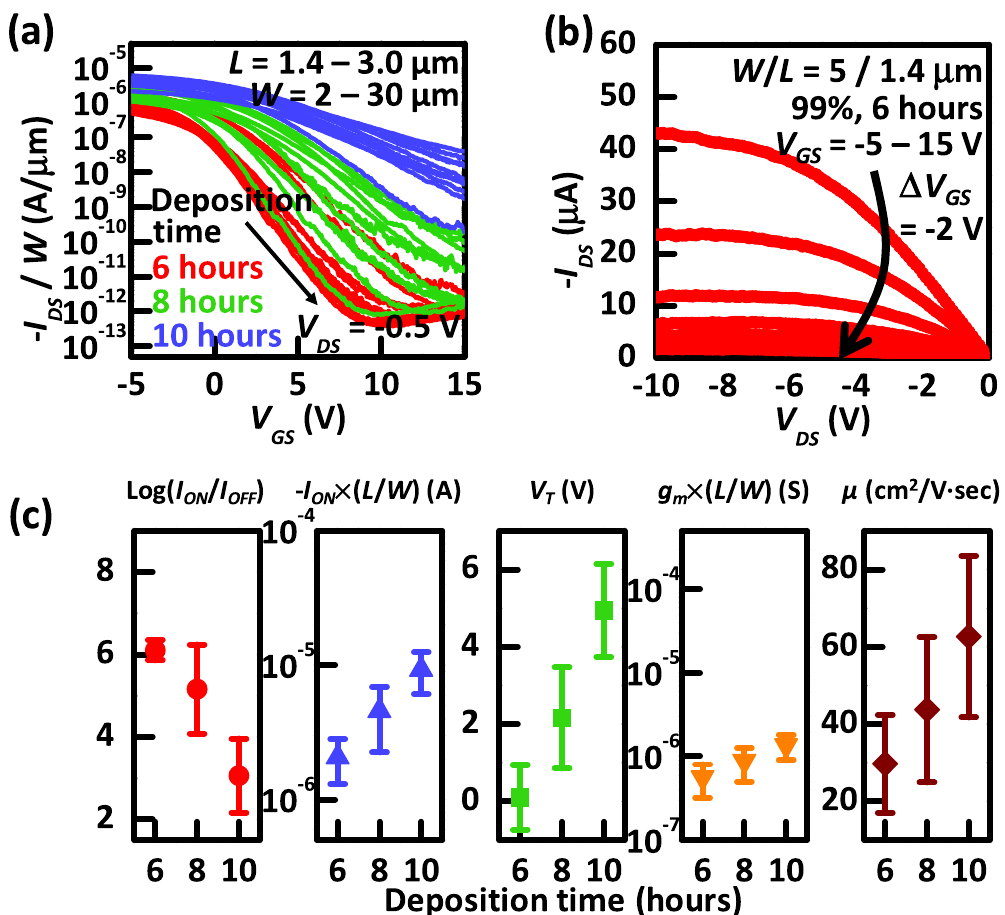
Figure 2. ( a ) Transfer characteristics ( I DS - V GS ) of three sets of CNT-TFTs produced for different CNT densities in the network channel. ( b ) Output characteristics ( I DS - V DS ) of a CNT-TFT fabricated from a deposition time of 6 h. ( c ) Log( I ON / I OFF ), normalized on-state current ( I ON ), threshold voltage ( V T ), normalized transconductance ( g m ), and mobility ( µ ) for CNT-TFTs with different densities of